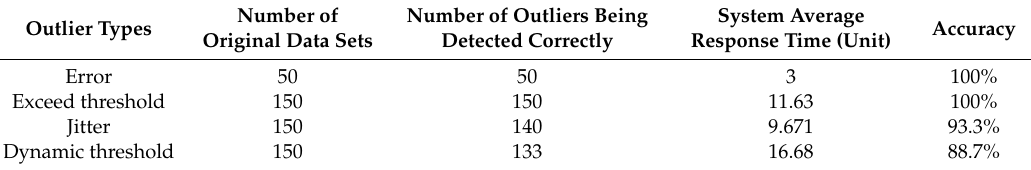
Table A3. Statistical outcomes of the experiment (sampling rate = 1 / 10 sec , network scale = 10,000 nodes). Outlier Types